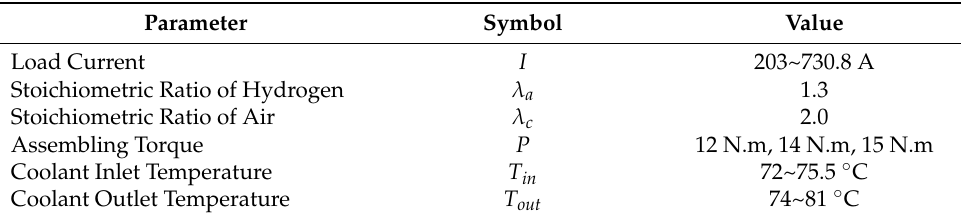
Table 1. Operating